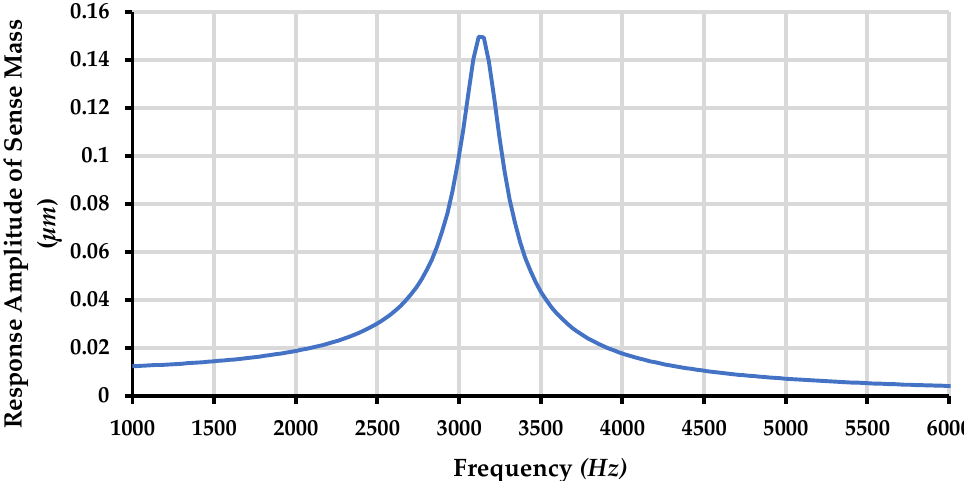
Figure 20. Response amplitude of the sense mass m 3 of the proposed MEMS gyroscope for ambient conditions.